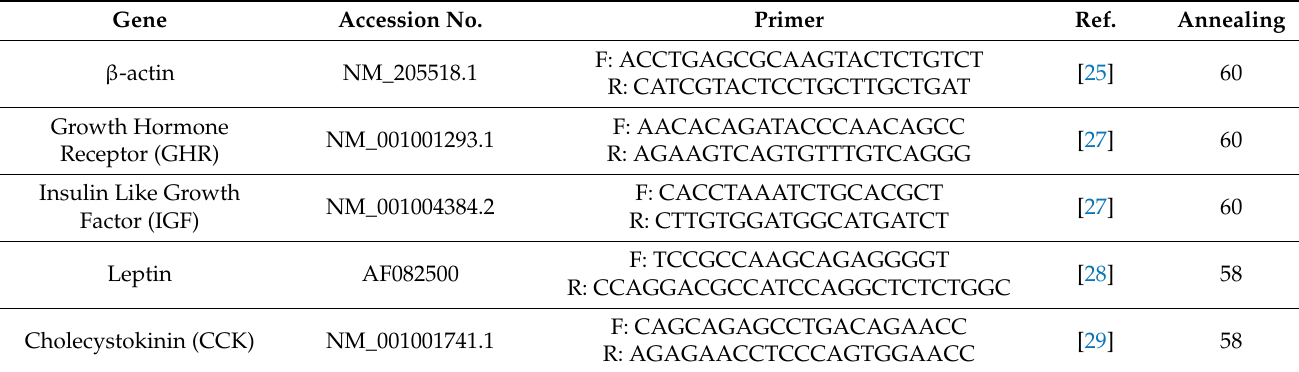
Table 3. Gene-specific primers sequence used in the